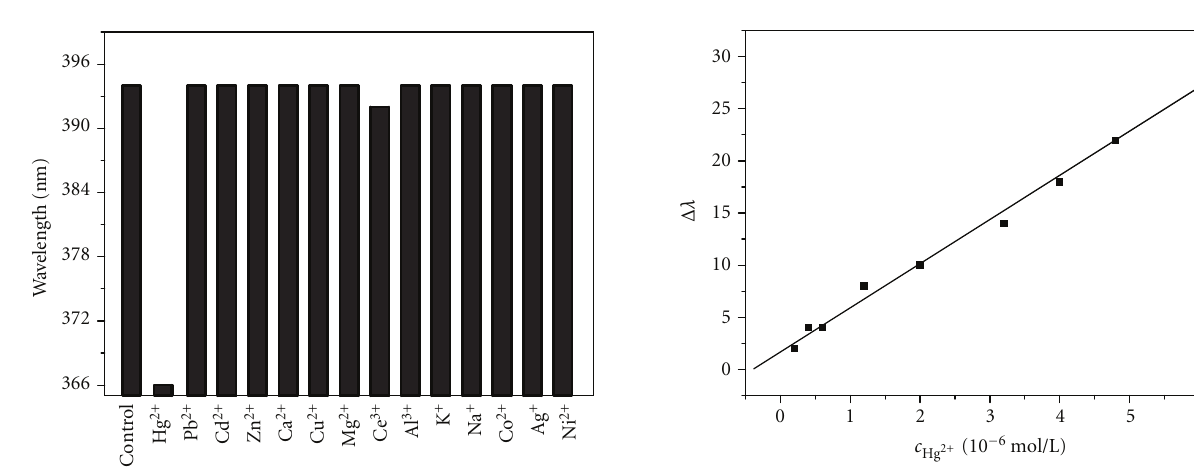
Figure 7: The blue shift of the maximum absorption wavelength of AgNPs and Hg (II) ion concentration. A linear correlation exists Table 1: The results of synthetic samples. Samples Main interferes